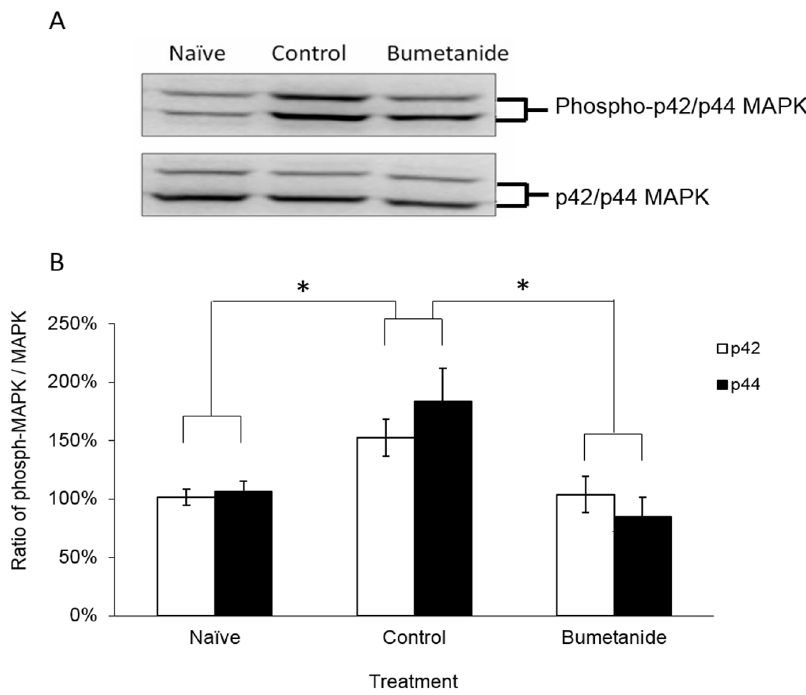
Figure 4. Systemic administration of bumetanide blocked avoidance learning induced MAPK activation in hippocampus. (A) Representative Western blots among different groups. (B) Densitometric analysis of the activation of MAPK in the hippocampus under different treatments. MAPK phosphorylation was significantly elevated in hippocampus after inhibitory avoidance learning. Bumetanide treatment significantly reduced the phosphorylation level of MAPK compared with vehicle-treated group (Values are mean 6 SEM, * P , 0.05 versus vehicle-treated